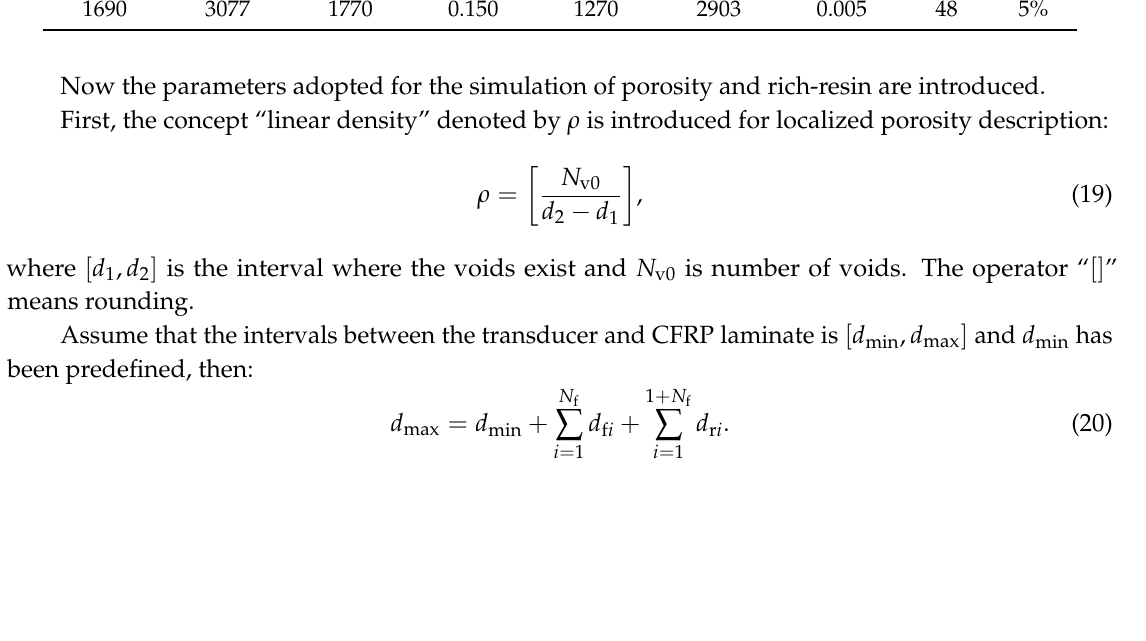
Table 1. Parameters of materials.